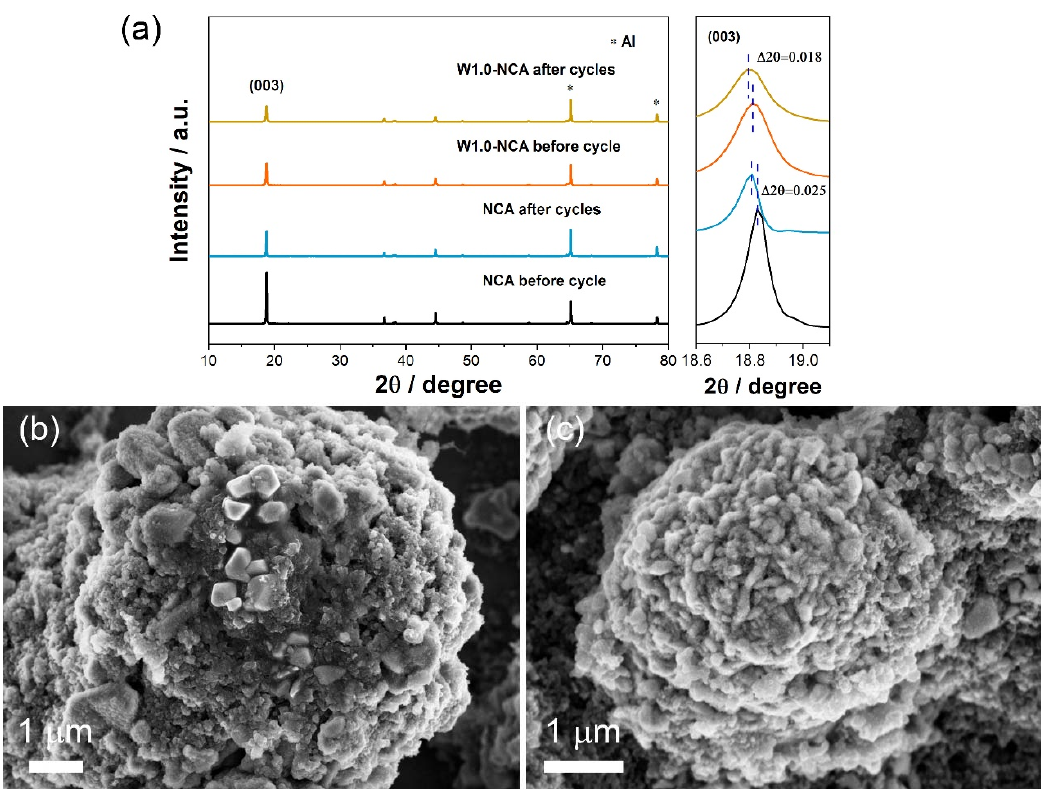
Figure 8. ( a ) XRD patterns of NCA and w1.0-NCA before and after 100 cycles, and the homolo- gous magnified diffraction peaks (003). SEM images after 100 cycles of ( b ) NCA and ( c ) W1.0-